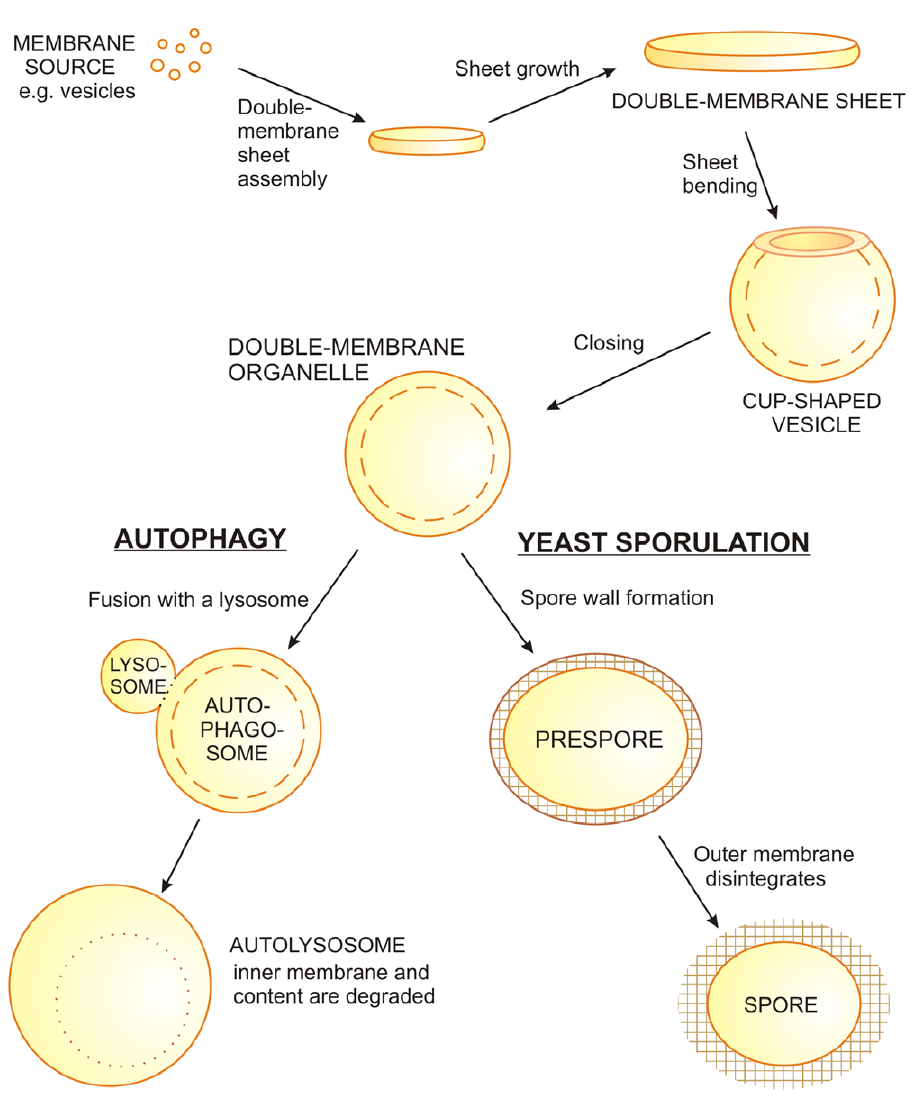
Figure 1. Growth and fate of cup-shaped vesicles in cells. Double-membrane sheets can be built by fusing small vesicles. The sheets grow to a critical size, bend and eventually close to form a double-membrane organelle, for intermediate states see Fig. 2. In the autophagosomal pathway, autophagosomes fuse with lysosomes. In the resulting autolysosome, the cytosolic content of the autophagosome becomes degraded together with the inner vesicle membrane. In the yeast sporulation pathway, a spore wall is synthesized between both membranes to build the prespore. The completed spore has only one membrane, because during spore wall assembly the outer membrane disintegrates.